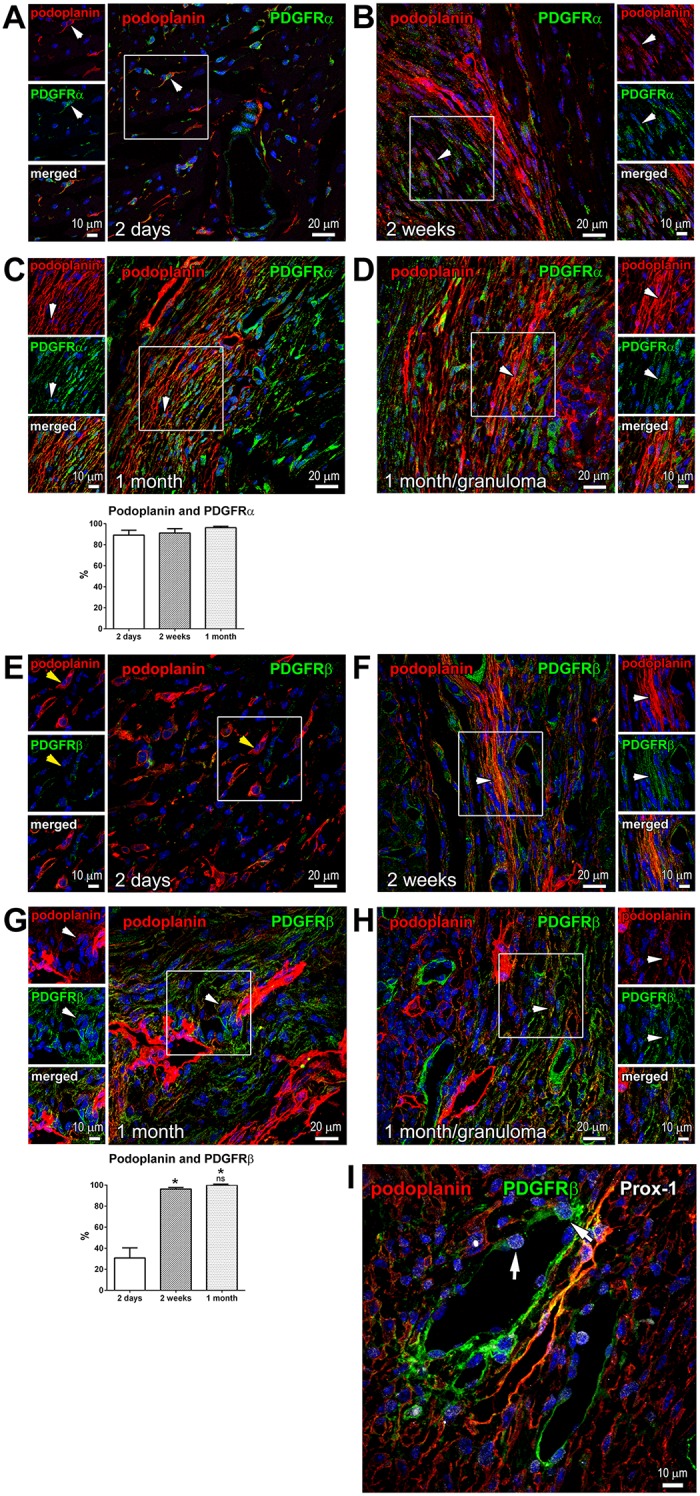
Expression of PDGFRα and PDGFRβ in podoplanin-positive populations.Thin cardiac sections were indirectly immunolabeled with podoplanin (red) and either PDGFRα (A-D; green), PDGFRβ (E-H; green), or PDGFRβ and Prox-1 (I; green and grey, respectively) antibodies. Nuclei, blue. In A-H, time after MI is indicated. Areas in rectangles are shown in the adjacent images for each color channel and merged. In A-D, podoplanin is frequently co-stained with PDGFRα at every time point; examples are indicated by white arrowheads. In E, podoplanin-positive cells are mostly PDGFRβ-negative, as exemplified by yellow arrowheads. In F-H, PDGFRβ distinctly co-stained with podoplanin. In C and G, quantitative image analyses (graphs, lower panels) of the fraction of podoplanin-expressing cells co-labeled with PDGFRα (C) or PDGFRβ (G) are shown at indicated times after MI. Data represent mean and SD of the % double-positive cells out of total podoplanin-positive cells; n = 5 image fields per group. By one-way ANOVA for PDGFRβ, *P < 0.0001 for 2 days vs. 2 weeks or 1 month; ns, not-significant for 1 month vs. 2 weeks. In I, arrows point to the examples of Prox-1 staining in the nuclei of PDGFRβ-positive podoplanin-negative BVs.